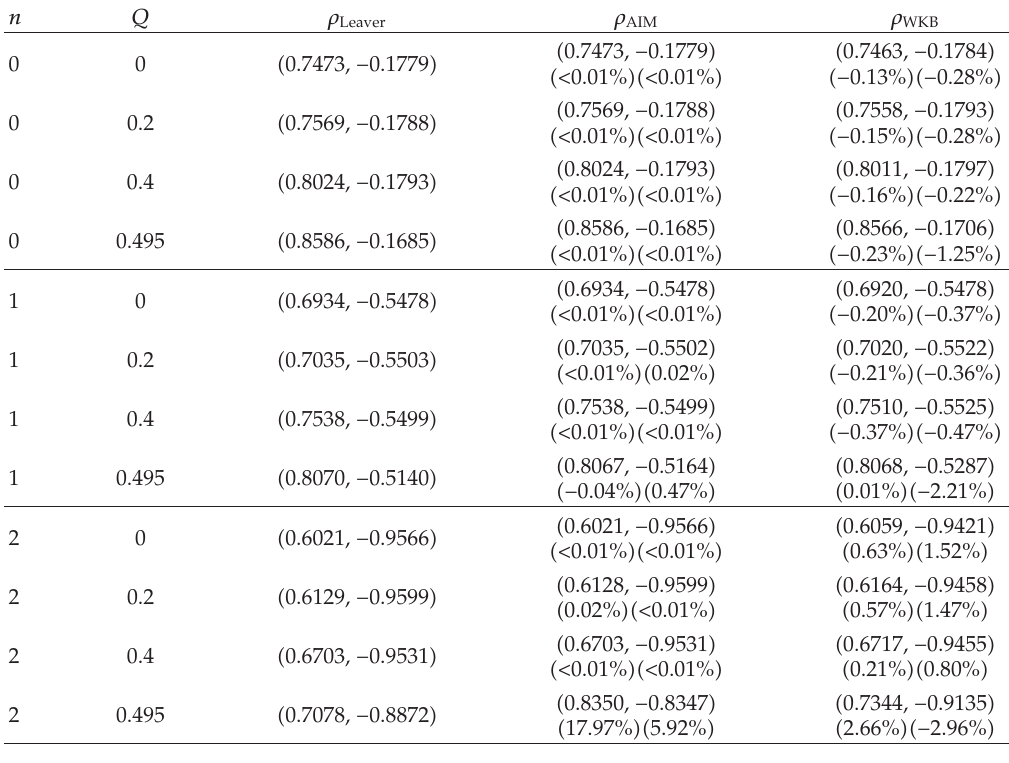
Table 4: Reissner-Nordstr¨om quasinormal frequency parameter values (cid:2) ρ (cid:8) − iω (cid:3) for the fundamental (cid:2) n (cid:8) 0 (cid:3) and two lowest overtones for l (cid:8) 2 and i (cid:8)